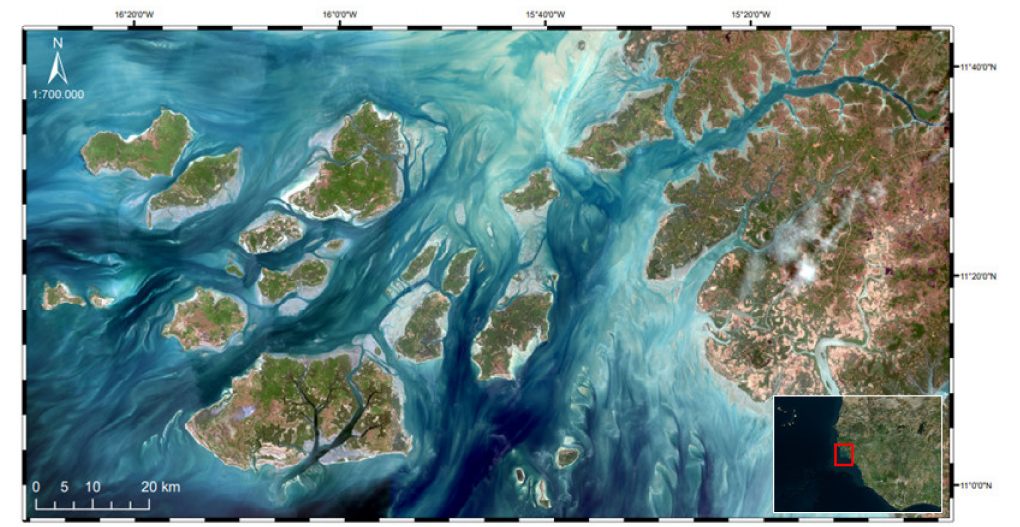
Figure 2. The Bijag ó s archipelago in Guinea-Bissau. RGB composite after atmospheric correction of Sentinel-2B imagery on 25 April